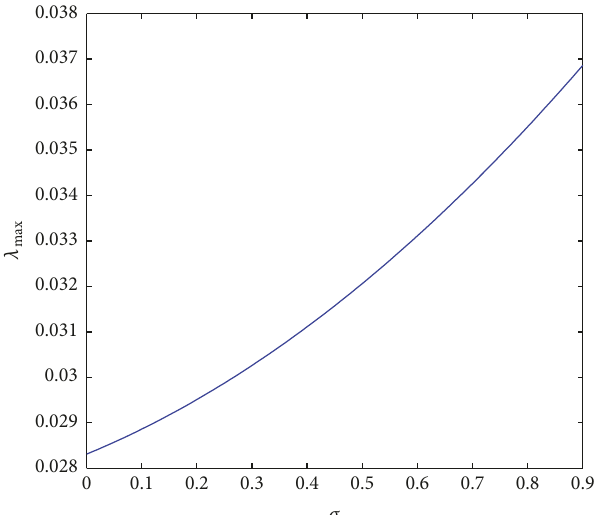
Figure 5: The maximal Lyapunov exponent in linear coupling case in (5a)–(5h). The parameter is fixed as 𝛼 = 0.1 .